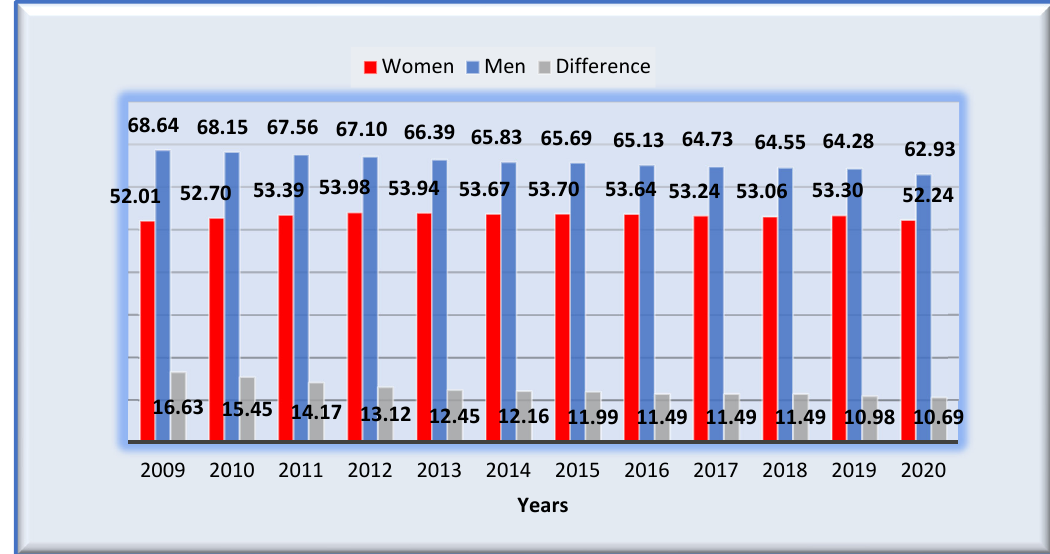
Figure 1. Activity rates by sex (percentages). Source: Authors with data from the Statistics National Institute ( Instituto Nacional de Estadística ).